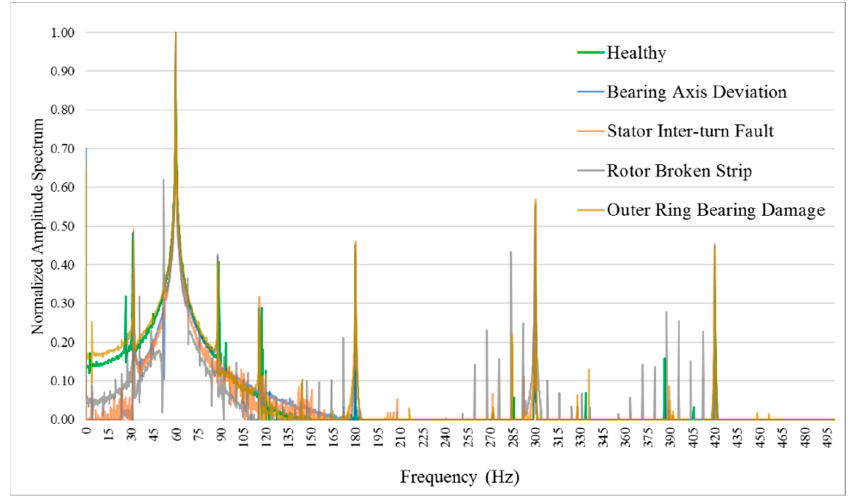
Figure 5. Frequency occurrence plots of five motor fault conditions under five loading conditions.